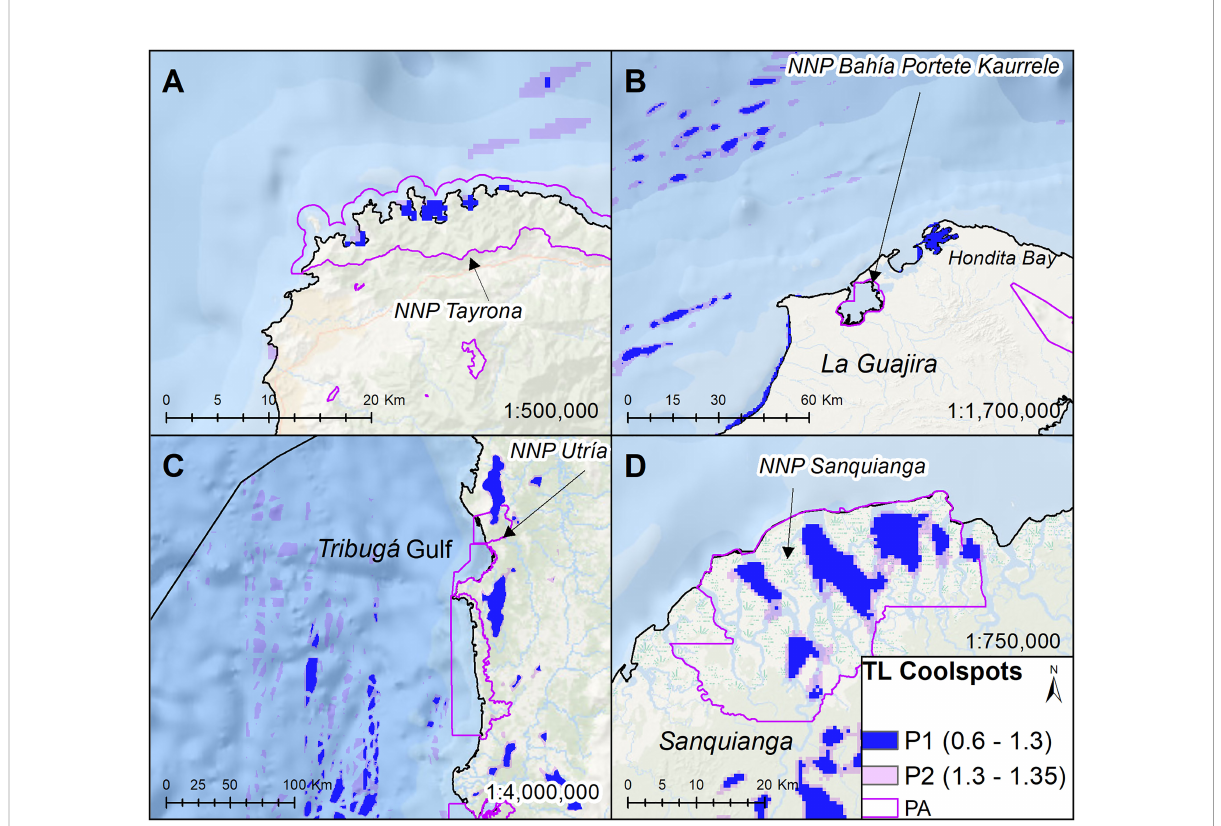
FIGURE 4 Threat coldspots. (A) NNP Tayrona at MAG ecozone, (B) adjacent areas to continental shelf and Hondita Bay at La Guajira , (C) Tribuga ́ Gulf, and (D) NNP Sanquianga . The location of these coldspots within the national territory of Colombia is shown in Figure 2. TL values (in brackets) were ranked by percentile 1 (P1) and percentile 2 (P2) revealing threat coldspots. NDIM, National District of Integrated Management; NNP, National Natural Park; PA, protected